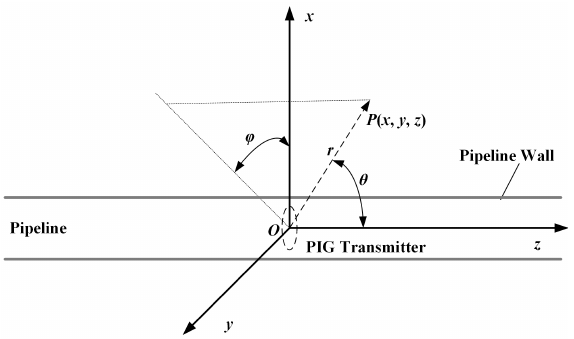
Figure 2. The magnetic dipole model for tracking system. The circle part is one turn of the transmit- ting coil and represents a magnetic